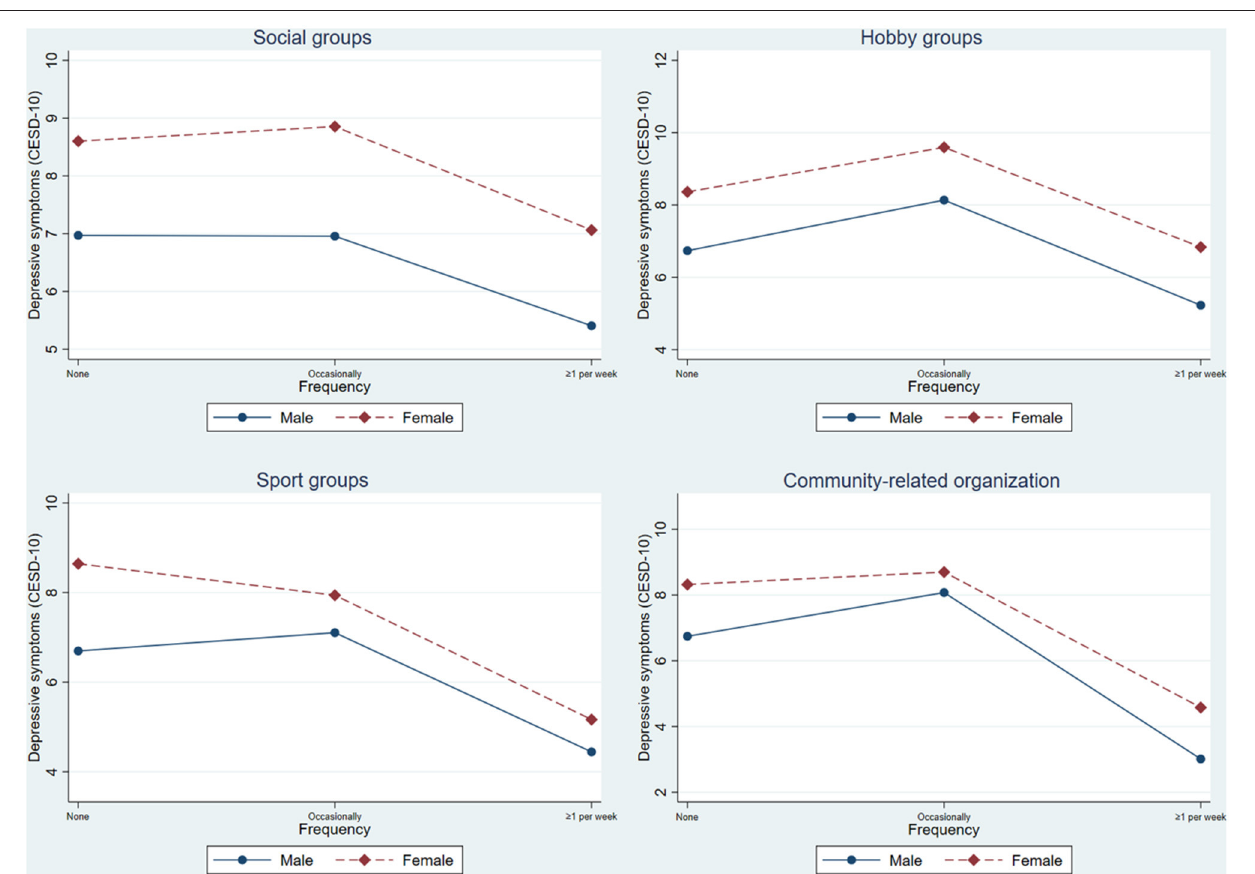
FIGURE 2 | The interaction effect between gender and social participation on CESD-10 scores among older adults.